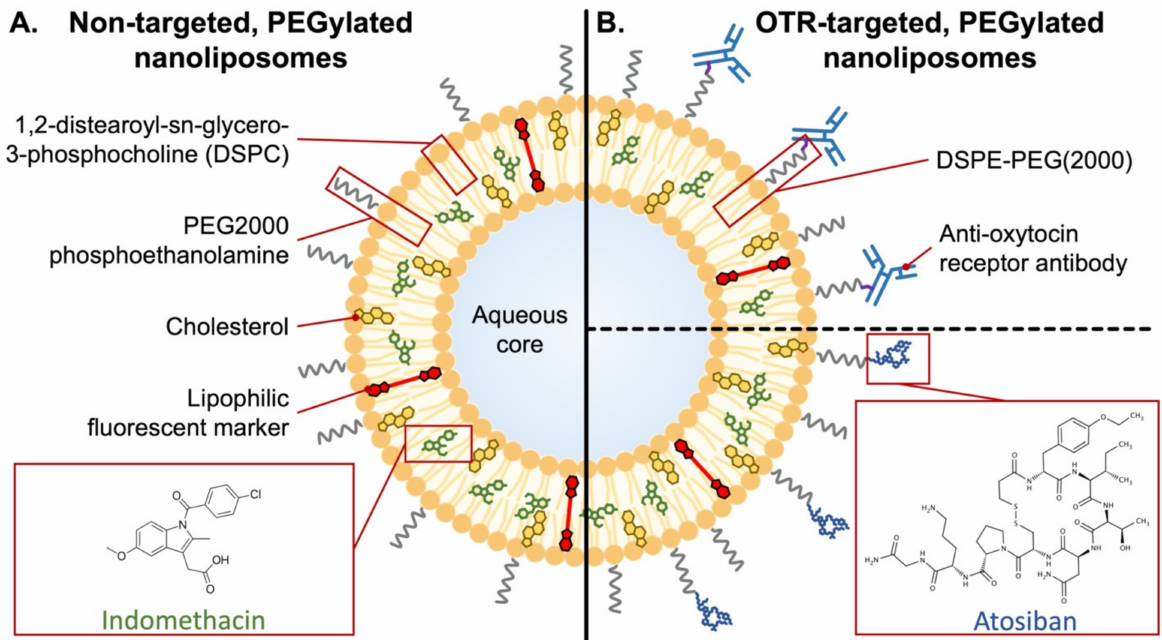
Figure 4. Schematic of non-targeted and uterine-targeted nanoliposomes. ( A ) The nanoliposomes are composed primarily of 1,2-distearoyl-sn-glycero-3-phosphocholine (DSPC) and cholesterol but also include PEGylated lipid (PEG2000 phospho- ethanolamine; ~2% of total lipids), which produces steric hindrance that improves circulation time, but without a targeting moiety. Indomethacin and lipophilic markers partition into the lipid bilayer. ( B ) Oxytocin receptor (OTR)-targeted nanolipo- somes, whereby PEGylated 1,2-distearoyl-sn-glycero-3-phosphoethanolamine (DSPE, ~2% of total lipids) is conjugated to either an OTR-binding antibody (via maleimide linkage) or peptide (Atosiban, via amine